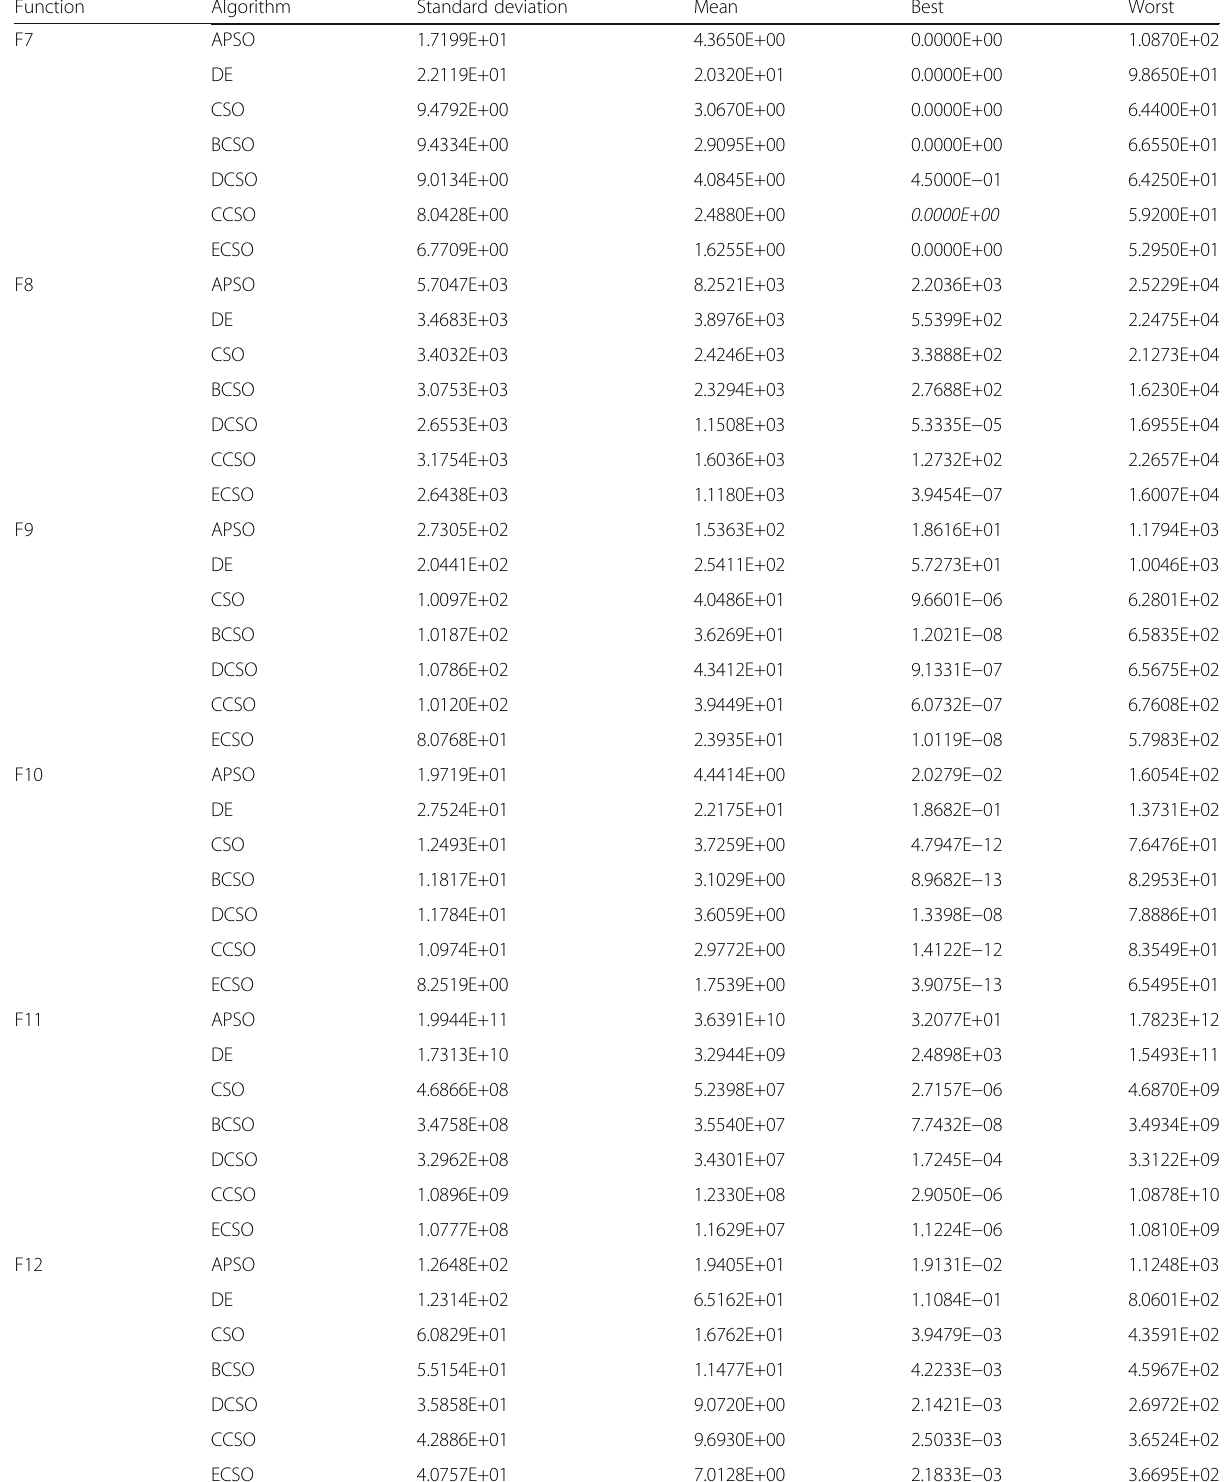
Table 4 Performance comparison of all algorithms based on benchmark functions F7 – F12